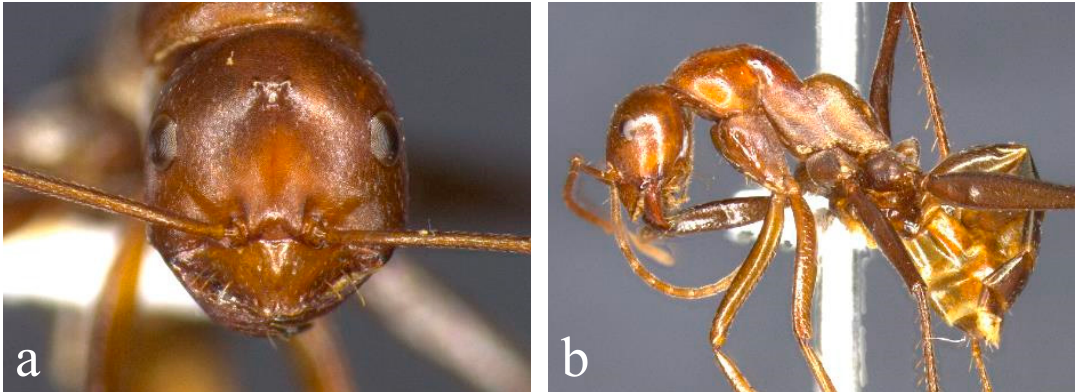
a b Figure 9. Morphology of Taxon 1Q from the sp. 1 complex. Head ( a ) and lateral view ( b ) of minor worker (BOLD ID: MELPS071-18). This taxon is known only from Berry Springs, NT. The final primary clade represents the sp. 35 complex, and it indicates that sp. 35 also